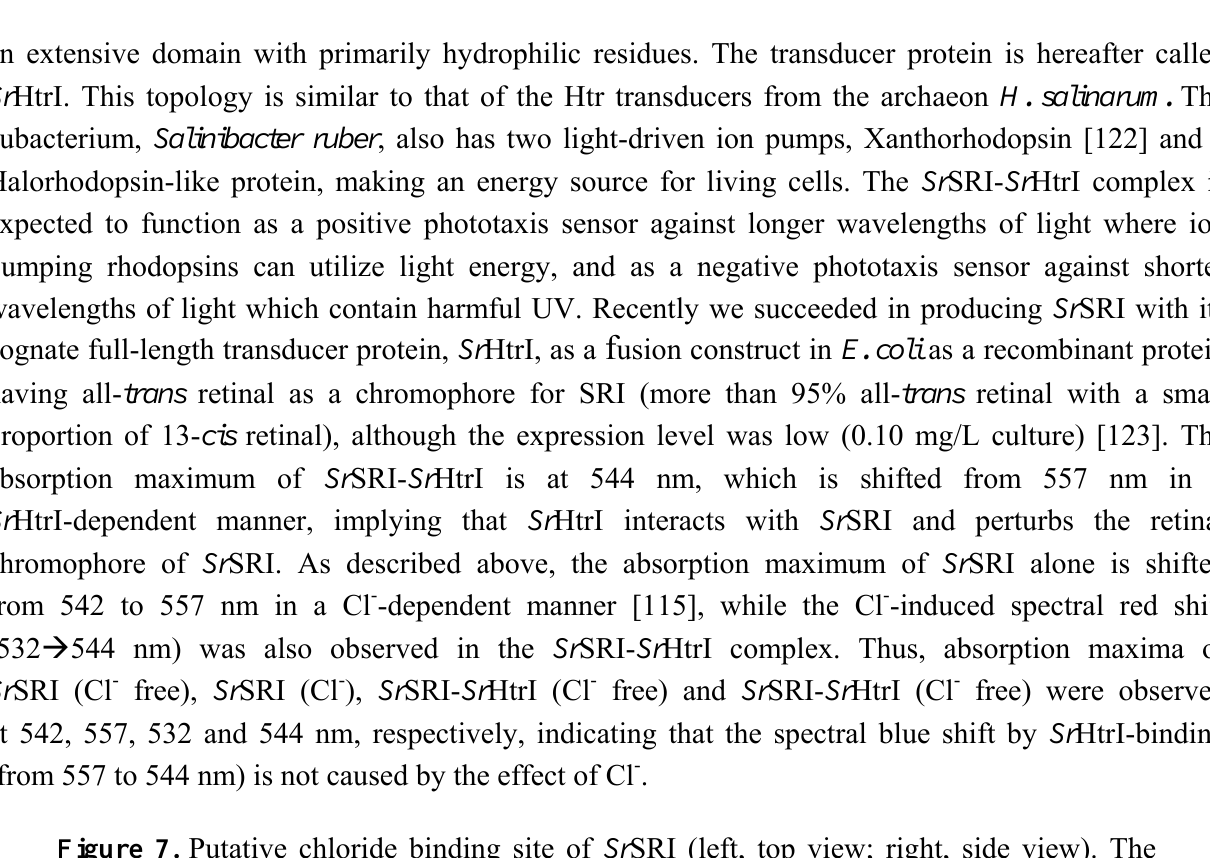
Figure 7. Putative chloride binding site of Sr SRI (left, top view; right, side view). The structure was generated using a theoretical model of Hs SRI (PDB ID: 1SR1) [121]. It was assumed that a positive charge located on the Schiff base nitrogen is likely to move to the b-ionone ring by chloride ion binding to